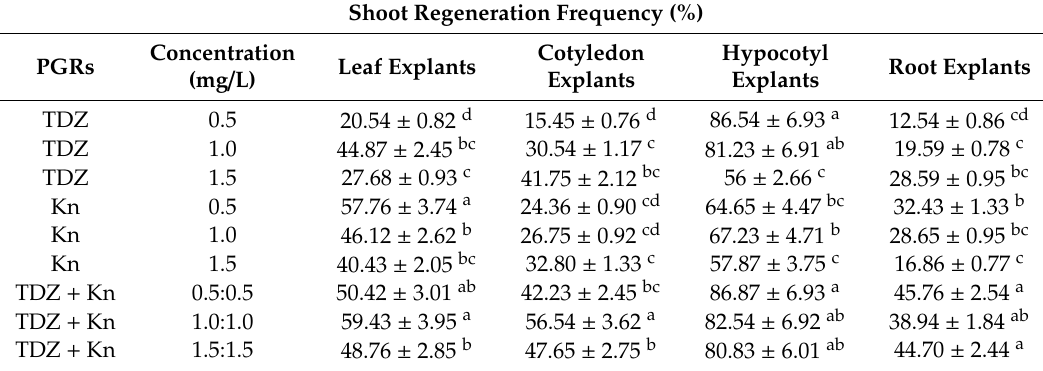
Table 1. Selection of suitable explant type and plant growth regulators (PGRs) for micropropagation through shoot organogenesis in L. usitatissimum . Values represent mean data of each treatment with ± standard error. Data was collected after four weeks culture period. Data with di ff erent letter(s) is statistically significant at p ≤ 0.5. TDZ: thidiazuron, Kn: Kinetin. Shoot Regeneration Frequency